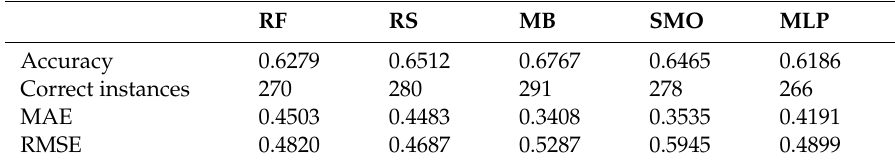
Table 2. Performance of the classification-based models.